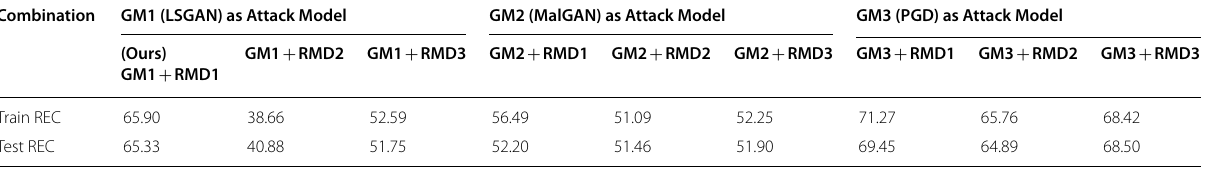
Table 14 The recognition rate comparision of different combinations (%) Combination GM1 (LSGAN) as Attack Model GM2 (MalGAN) as Attack Model GM3 (PGD) as Attack